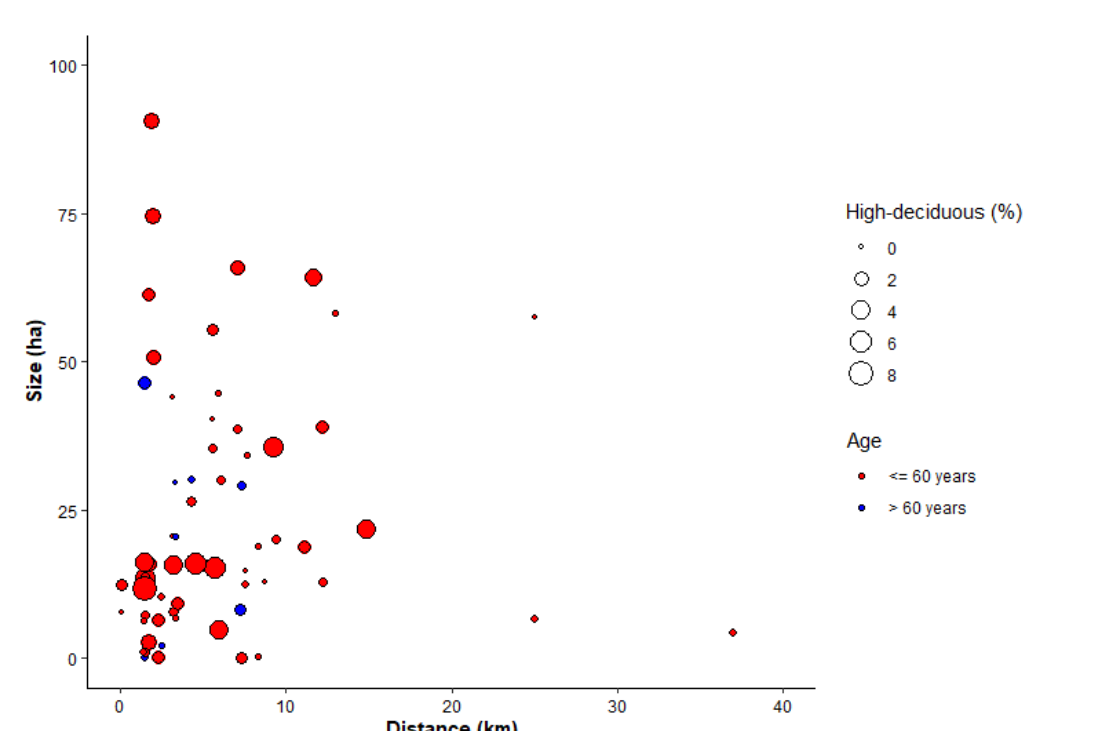
Figure 6. Density map showing (1) the areas with the highest density of stands with a high percentage of deciduous trees (>75%) and (2) locations of the restored sites for the entire study area and a portion of the study region with highest densities. The % values show the percentage of high-deciduous forest per 500 ha in that specific area.